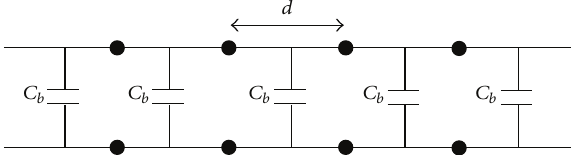
Figure7:EquivalentcircuitoftheMPGSstructurewithperiodically loaded capacitor 𝐶 𝑏 .